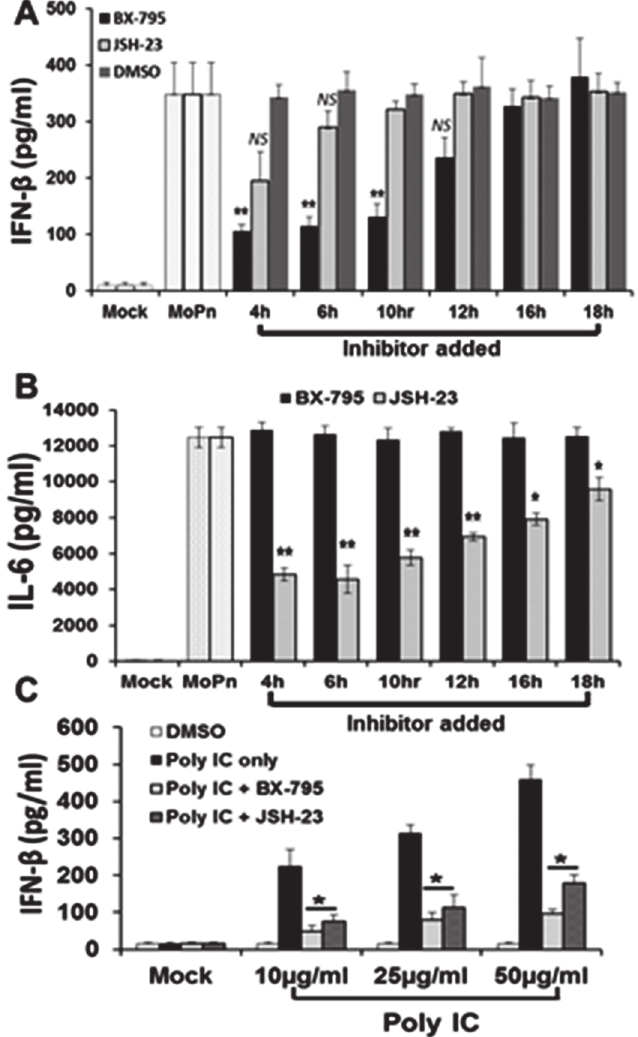
Fig 6. Inhibition of IRF3 and NF- κ B affects early synthesis of IFN- β induced during Chlamydia infection. (A) Bm1.1 cells were infected with 10 IFU/ cell C . muridarum up until the indicated time-points when the media was supplemented with either the IRF3 inhibitor BX-795, the NF- κ B inhibitor JSH-23, or the solubilizing agent DMSO as a negative control. Cells were allowed to incubate in the presence of each inhibitor from the time indicated until cell supernatants were harvested at 24h PI, and IFN- β secreted was measured by ELISA. (B) C . muridarum -infected Bm1.11 cells were allowed to incubate in the presence of each inhibitor from the time indicated until cell supernatants were harvested at 24h PI, and IL-6 secreted was measured by ELISA. (C) Uninfected Bm1.11 cells were either DMSO-treated, transfected with 10, 25, or 50 μ g/ml poly-IC, or transfected with poly-IC prior adding the inhibitors BX-795 and JSH-23 to the cells 1h post-transfection. IFN- β secreted into the supernatants 24 h post transfection was measured by ELISA. The results shown are representative of three independent experiments . * = p < 0 . 05; ** = p < 0 . 01; NS = not statistically significant compared to poly-IC alone (C) , or 24h C . muridarum infection control without inhibitor (A and B; denoted as MoPn)